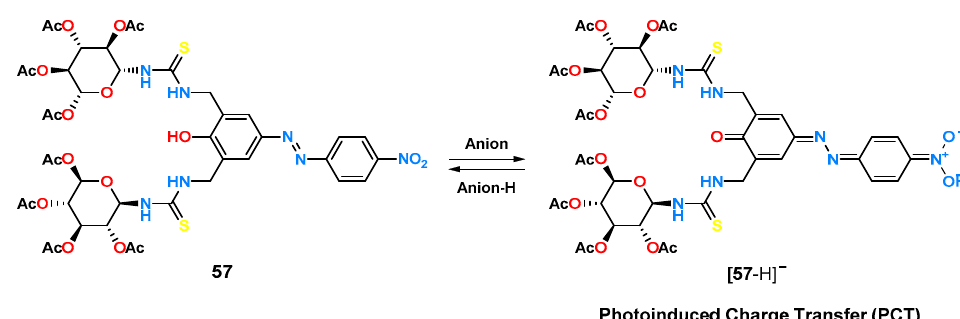
Figure 17. Chromophore receptor 57.